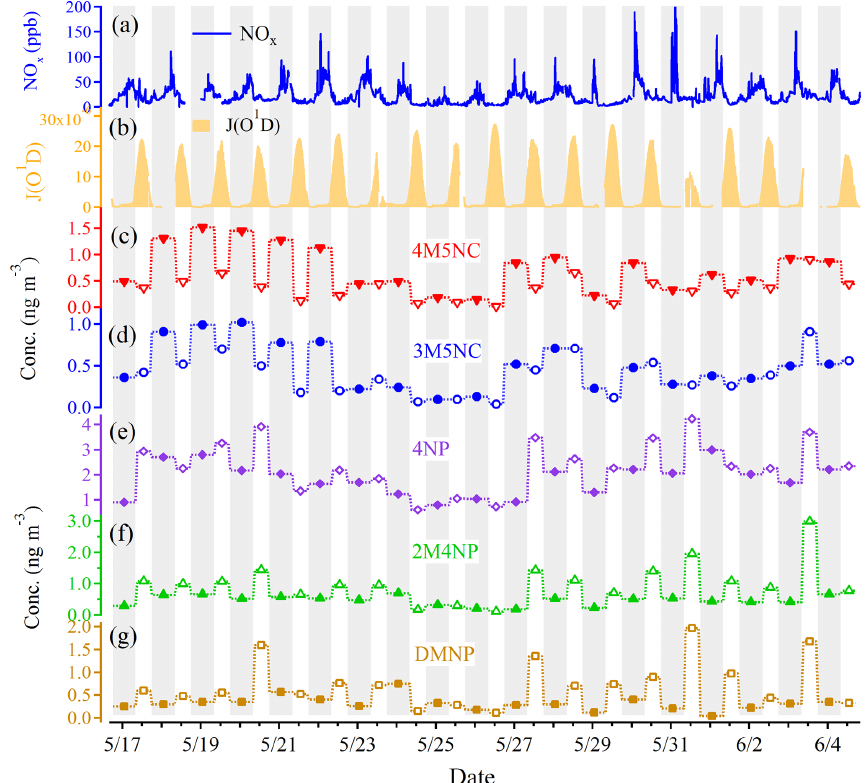
Figure 4. Time series of (a) NO x , (b) J(O 1 D), (c) 4-methyl-5-nitrocatechol (4M5NC), (d) 4-methyl-5-nitrocatechol (3M5NC), (e) 4- nitrophenol (4NP), (f) 2-methyl-4-nitrophenol (2M4NP), and (g) dimethyl-nitrophenol (DMNP). The gray background denotes the nighttime and the white background denotes the daytime.